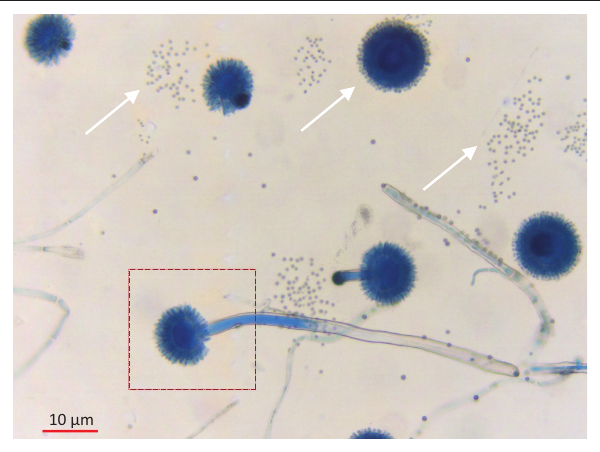
10 FIGURE 2: Microscopic view of Aspergillus niger stained with lactophenol cotton blue (binocular, light microscope: 200X). The arrows indicate roughened conidia. The box area highlights the conidiophore with a large vesicle, as well as the phialides and metulae covering the entire surface.